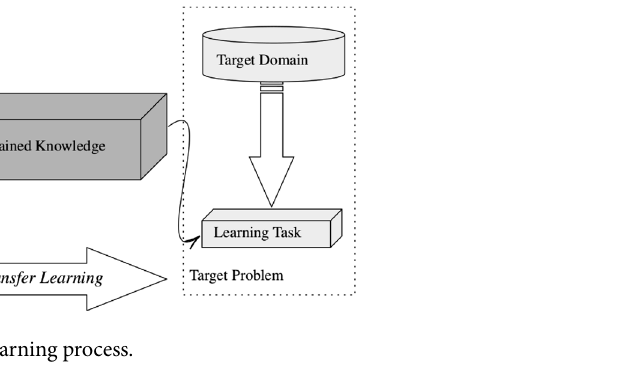
Figure 2. The transfer learning